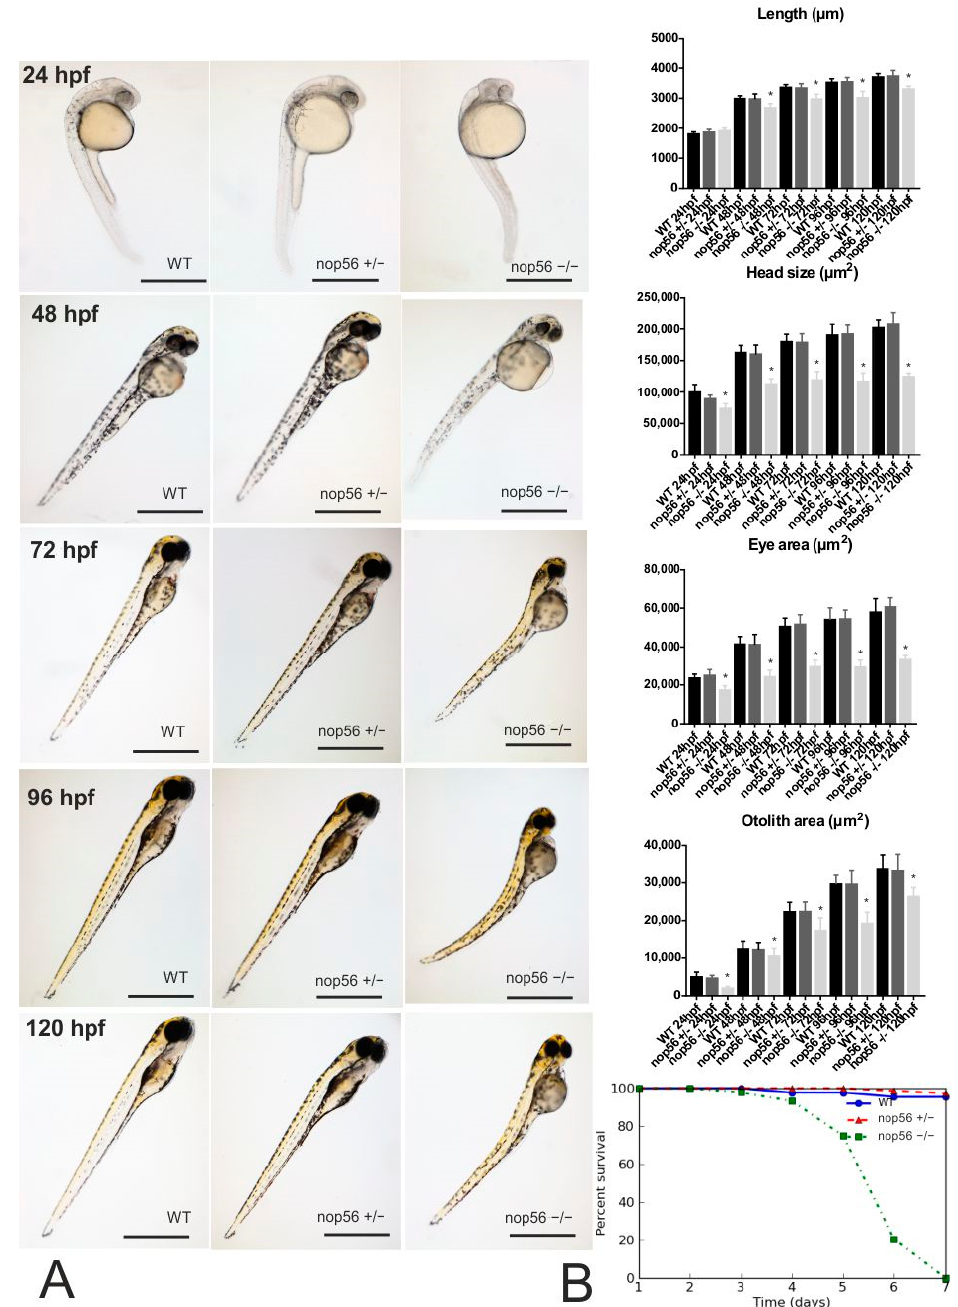
Figure 1. ( A ): Phenotype of wild-type, nop56 +/ − and nop56 − / − between 24 and 120 hpf. At 24 hpf, nop56 − / − show statistically significant reduced head size, smaller eyes and smaller. At 48 hpf, statistically significant reduced body length can be also observed in nop56 − / − embryos, as well as swollen yolk (in 100% of nop56 − / − embryos) and curved body shape in (40% of the nop56 − / − embryos). At 72 hpf, in addition to the previous features, there is cardiac edema in 77% of the embryos. In addition, at 96 and 120 hpf, there is total absence of swimming bladder in all nop56 − / − embryos, curved body shape (in 50% of nop56 − / − larvae) and a cardiac edema (in 88% of the nop56 − / − larvae at 96 hpf and 100% at 120 hpf). For these parameters, no statistically significant differences were observed between wild type and nop56 +/ − . Statistically significant data in the graphs are indicated with a *. Scale bar: 1000 µ m. ( B ) Kaplan–Meier survival graph for wild-type ( n = 43), nop56 +/ − ( n = 75) and nop56 − / − ( n = 44) zebrafish, revealing significantly different survivals for the nop56 − / − embryos p <